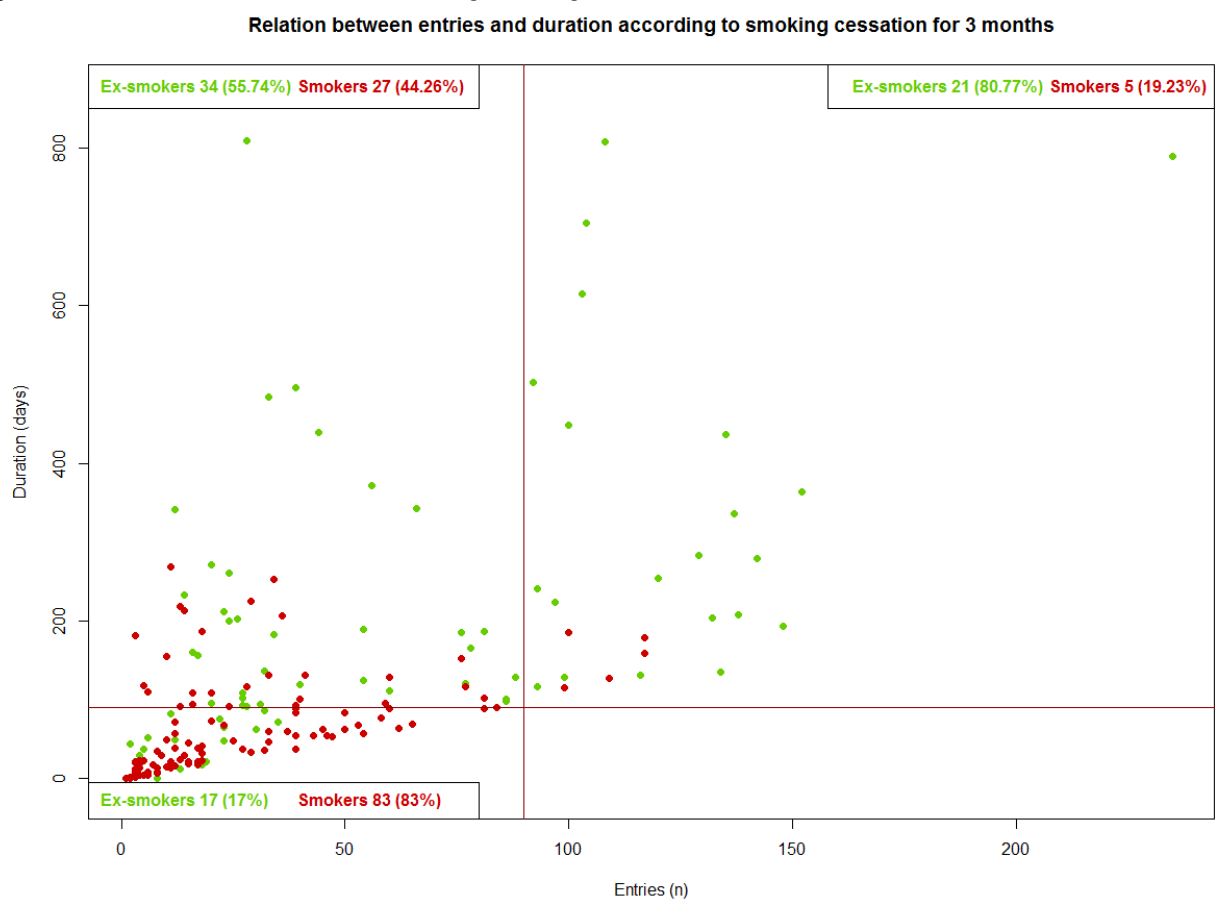
Figure 2. Relation between entries and duration according to smoking cessation for 3